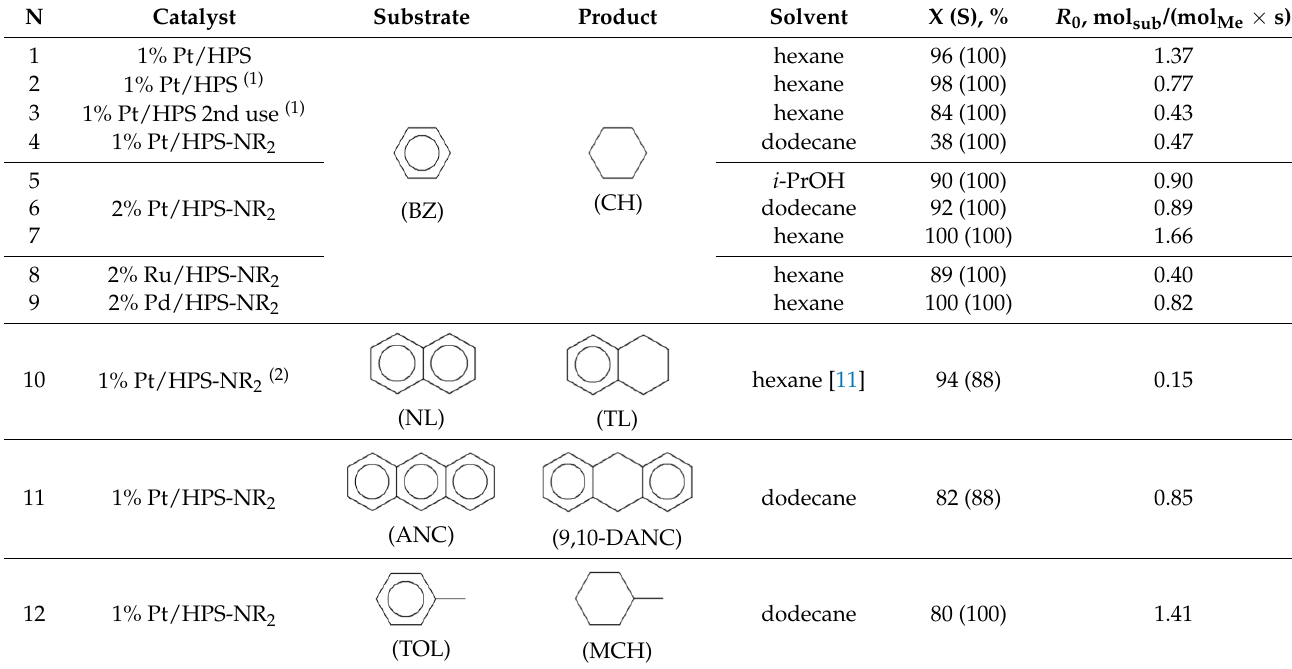
Molecules 2021 , 26 , x FOR PEER REVIEW 3 of 15